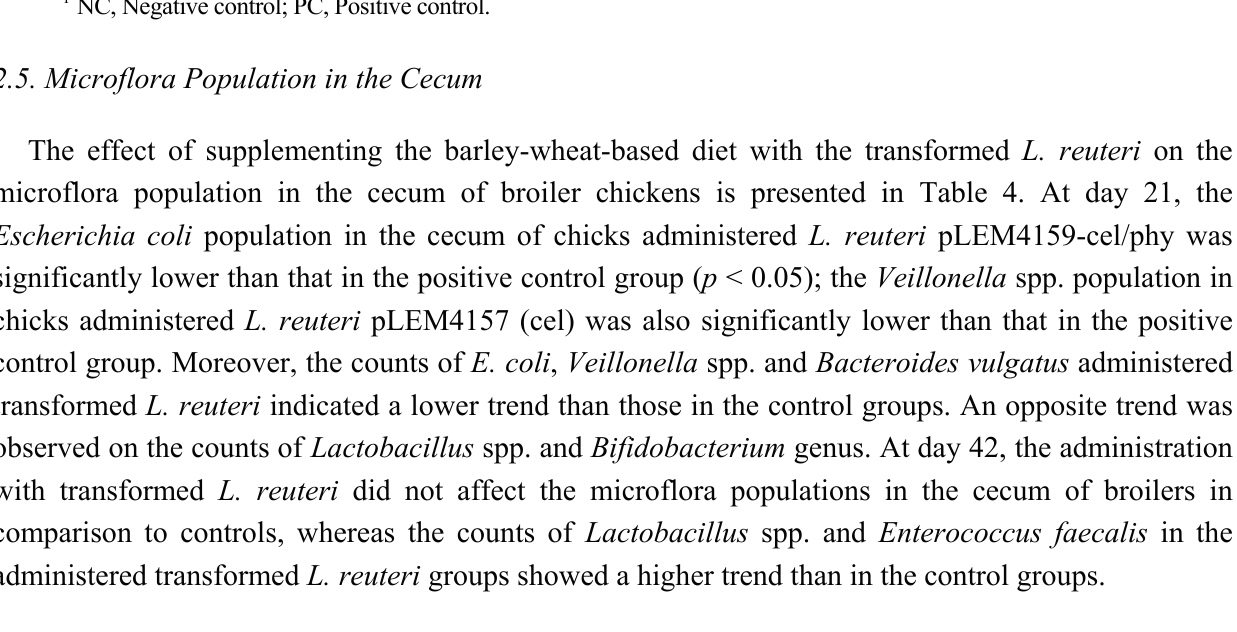
Table 4. Effect of transformed L. reuteri strain supplementation on the